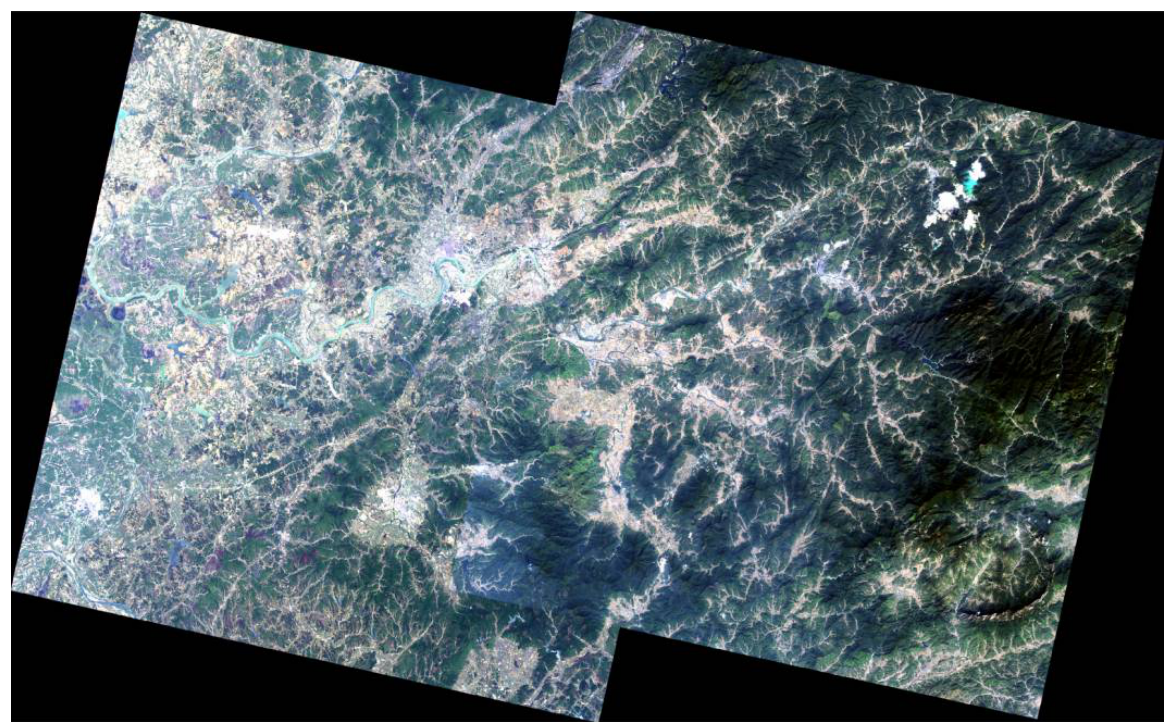
Figure 3. Two ALOS images showing the study